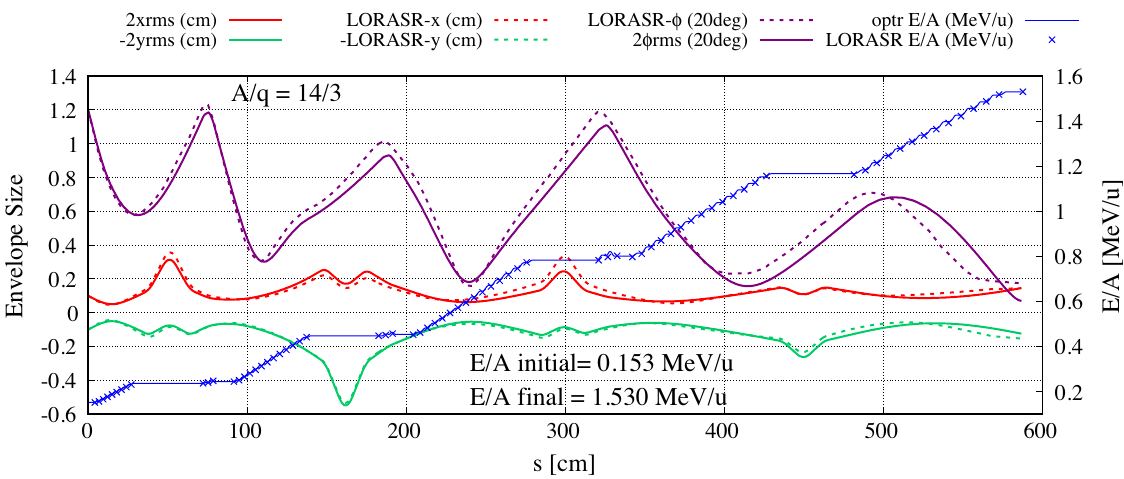
FIG. 5. Comparison of TRANSOPTR (solid, 2 rms) and LORASR (dashed, 96% containment) beam envelopes for 14 N 3 þ through the ISAC-DTL, for an initial distribution listed in Table II. In this simulation, the ISAC-DTL is configured for an E=A ¼ 1 . 530 MeV = u output, with tanks at negative synchronous phase. Longitudinal envelopes are presented in coordinate-5 units of 20° for plotting clarity, with ϕ ¼ 2 π z= ð βλ Þ .